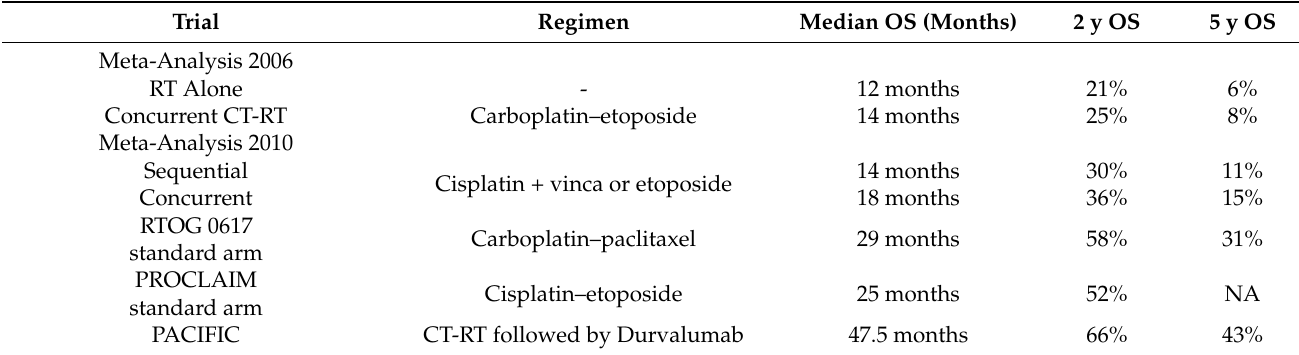
Table 1. Relevant trials and meta-analyses in the management of unresectable stage III non-small cell lung cancer, with data about regimens and overall